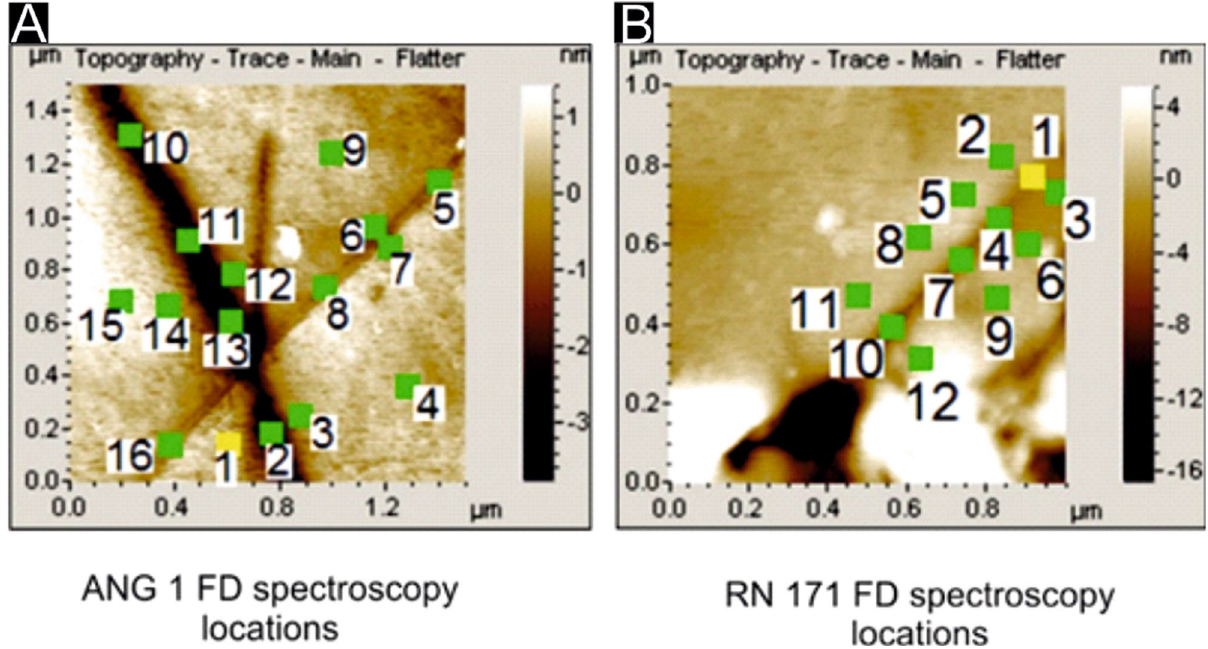
Figure 3. AFM images generated using PicoImage Basic Rendering Software (produced by Digital Surf), that comes integrated with Agilent PicoView Software (Version 1.14.4, Agilent Technologies) URL: https:// www. keysi ght. com/ in/ en/ lib/ softw are- detail/ instr ument- firmw are- softw are/ for- your- conve nience- you- can- now- downl oad- picov iew- and- pico- image- softw are- for- your- afm- 22822 56. html. Further, for better visual clarity, the numbers and the line profiles were drawn using MS Paint. Indent locations from which force-distance spectra have been obtained for two samples (A) ANG1 (B) RN171 are